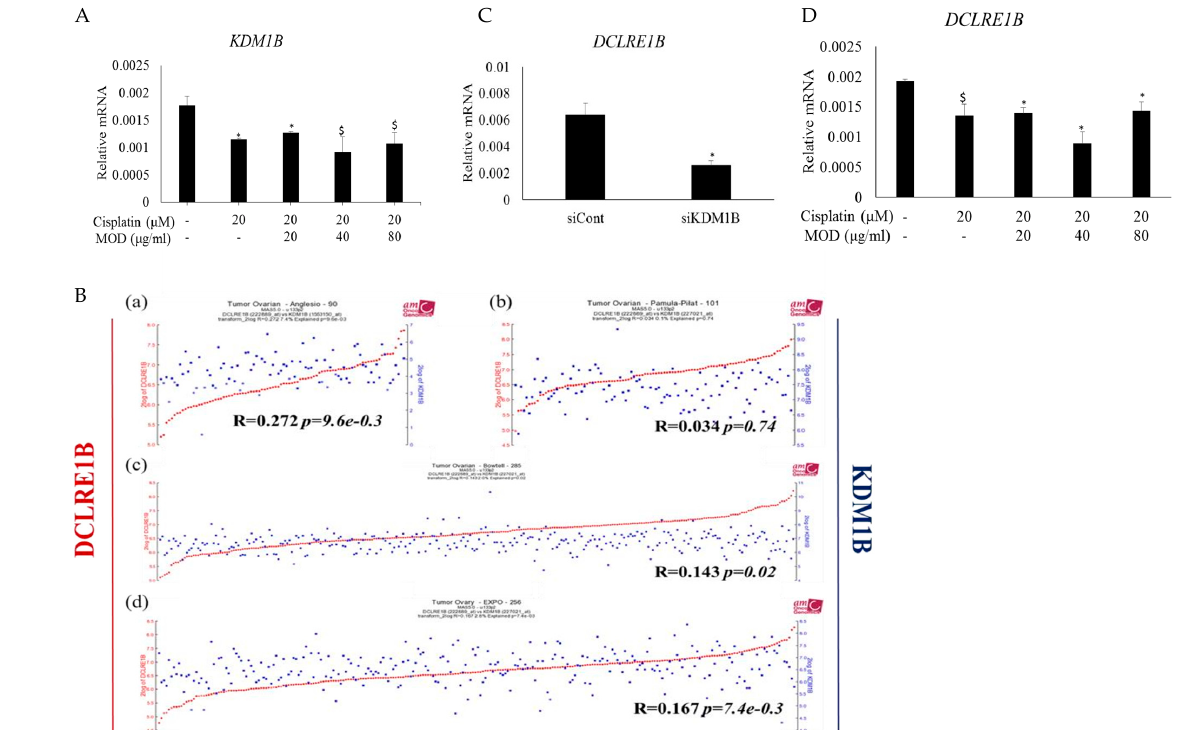
Figure 5. MOD enhancement of cisplatin sensitivity is correlated with KDM1B and DCLRE1B expression. Treatment of A2780cis cells with a combination of cisplatin and various concentrations of MOD for 48 h: ( A ) KDM1B and ( D ) DCLRE1B mRNA expression. ( B ) Correlation graphs between DCLRE1B and KDM1B gene expression from R2: microarray analysis and visualization platform (Available at: http: // r2.amc.nl) using cohorts from four di ff erent ovarian cancer patient datasets: ( a ) Anglesio-90, ( b ) Pamula-Pilat-101, ( c ) Bowtell-285 and ( d ) EXPO-256. ( C ) A2780cis were transfected with